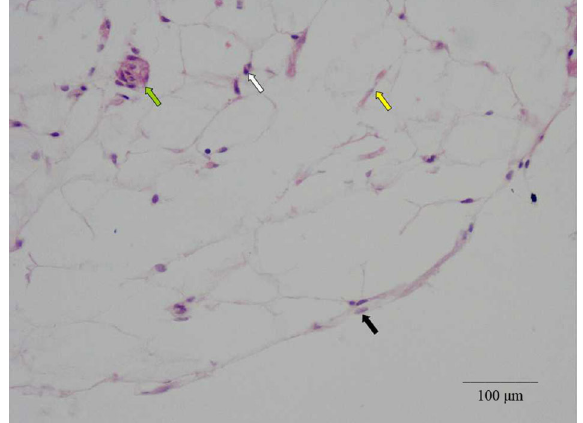
Figure 3. Hematoxylin-eosin staining of the serosa in a representative rat in group C1 (treated with sodium carbox- ymethyl cellulose [SCMC] ++ 3 mg dexamethasone). The serosa has a repaired dissection surface with continuous mesothelial cells (black arrow). No obvious fibroblastic proliferation was found. Capillary proliferation (green arrow), loose collagen fibers (yellow arrow), and a small number of scattered granulocytes and macrophages (white arrow) were observed (100 6